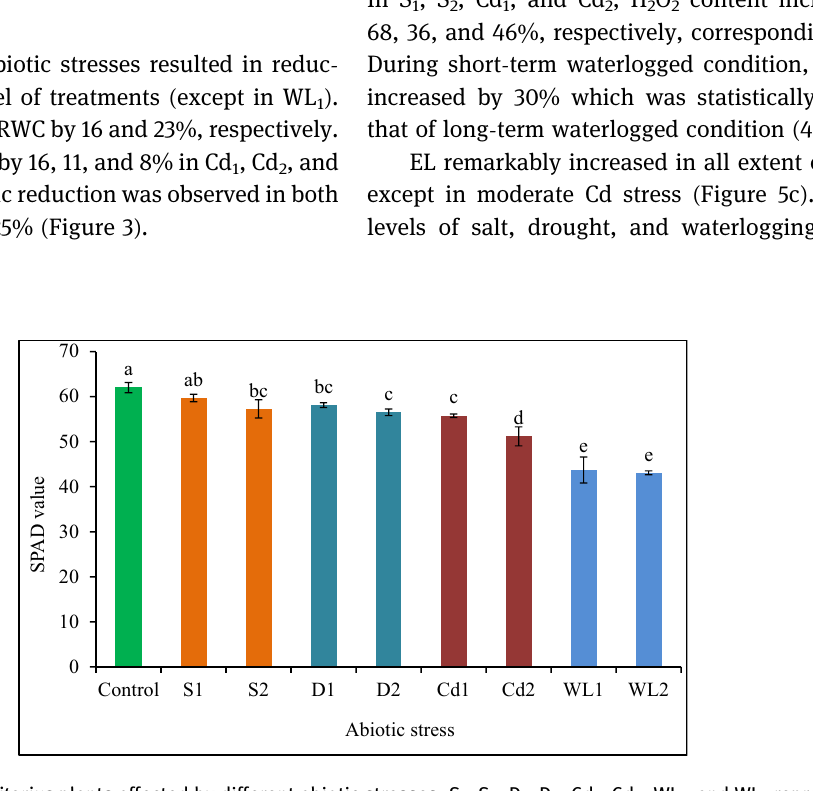
Figure 2: SPAD value of C. olitorius plants a ff ected by di ff erent abiotic stresses. S 1 , S 2 , D 1 , D 2 , Cd 1 , Cd 2 , WL 1 , and WL 2 represent 200 mM of NaCl, 400 mM of NaCl, 10 days of water de fi cit, 15 days of water de fi cit, 2 mM of CdCl 2 , 4 mM of CdCl 2 , 5 days of waterlogging, and 15 days of waterlogging, respectively. Mean value (± SD ) was calculated from three replicates for each treatment. Values in a column with di ff erent letters are signi fi cantly di ff erent at p ≤ 0.05 applying LSD